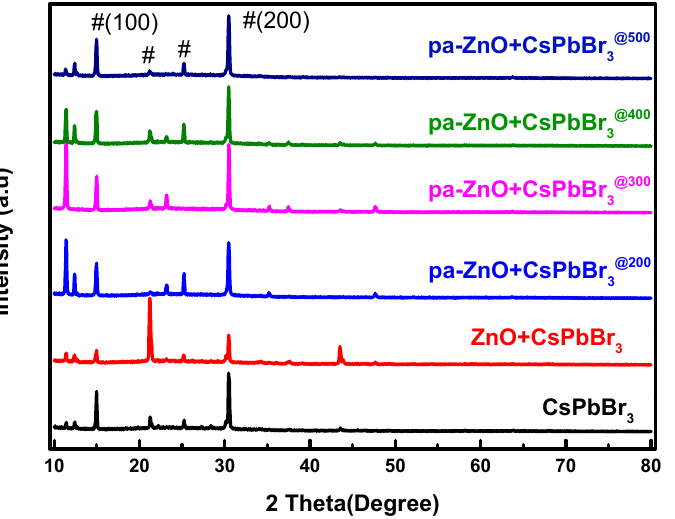
Figure 4. XRD pattern of pa-ZnO-doped CsPbBr 3 perovskite films with various pre-annealing tem- peratures.